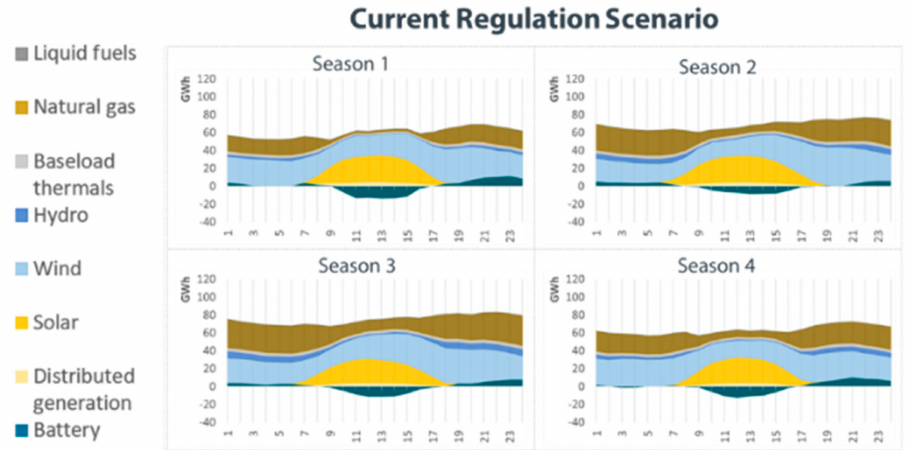
Figure 19. Generation profile per season in the current regulation scenario.